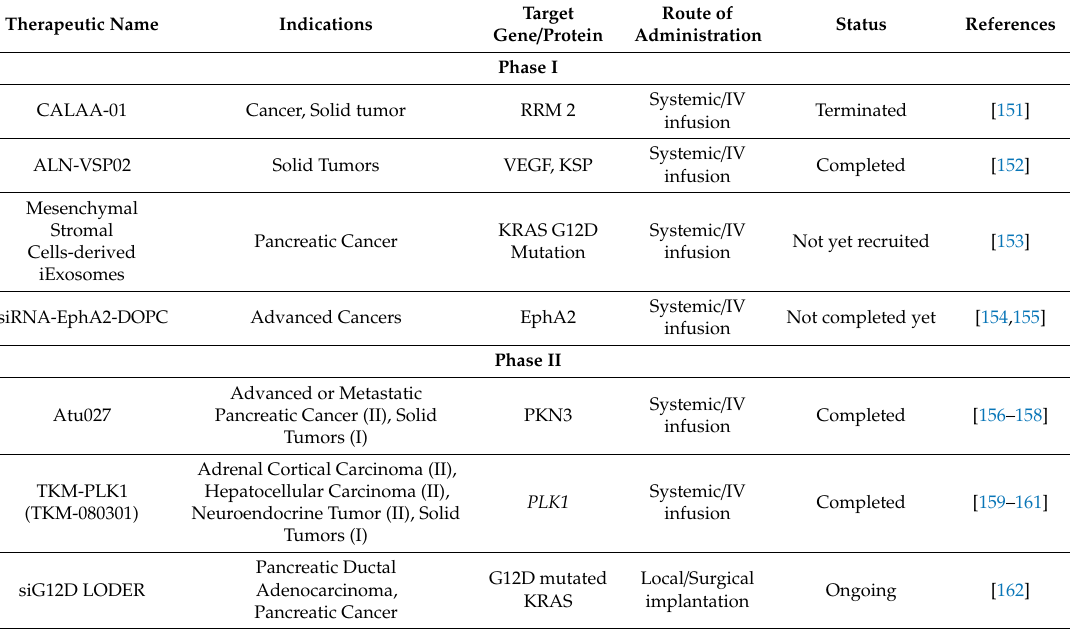
Figure 4. Representative diagram for the results of phase I and phase II clinical trials of the eight anticancer nano-siRNAs. Phase I trials of CALAA-01 and DCR-MYC were terminated. The phase I trial of siRNA-EphA2-DOPC has recruited but not completed yet, whereas the mesenchymal stem cell-derived exosomes with KRAS G12D trial has not yet recruited. ALN-VSP02, Atu027, TKM-PLK1, and siG12D LODER passed phase I successfully. Four siRNA nanotherapeutics moved to phase II; Atu027 and TKM-PLK1 completed phase II while siG12D LODER is currently being recruited. The phase II trial of DCR-MYC was terminated. Table 3. Anticancer siRNA-mediated nanoparticles in clinical trials.